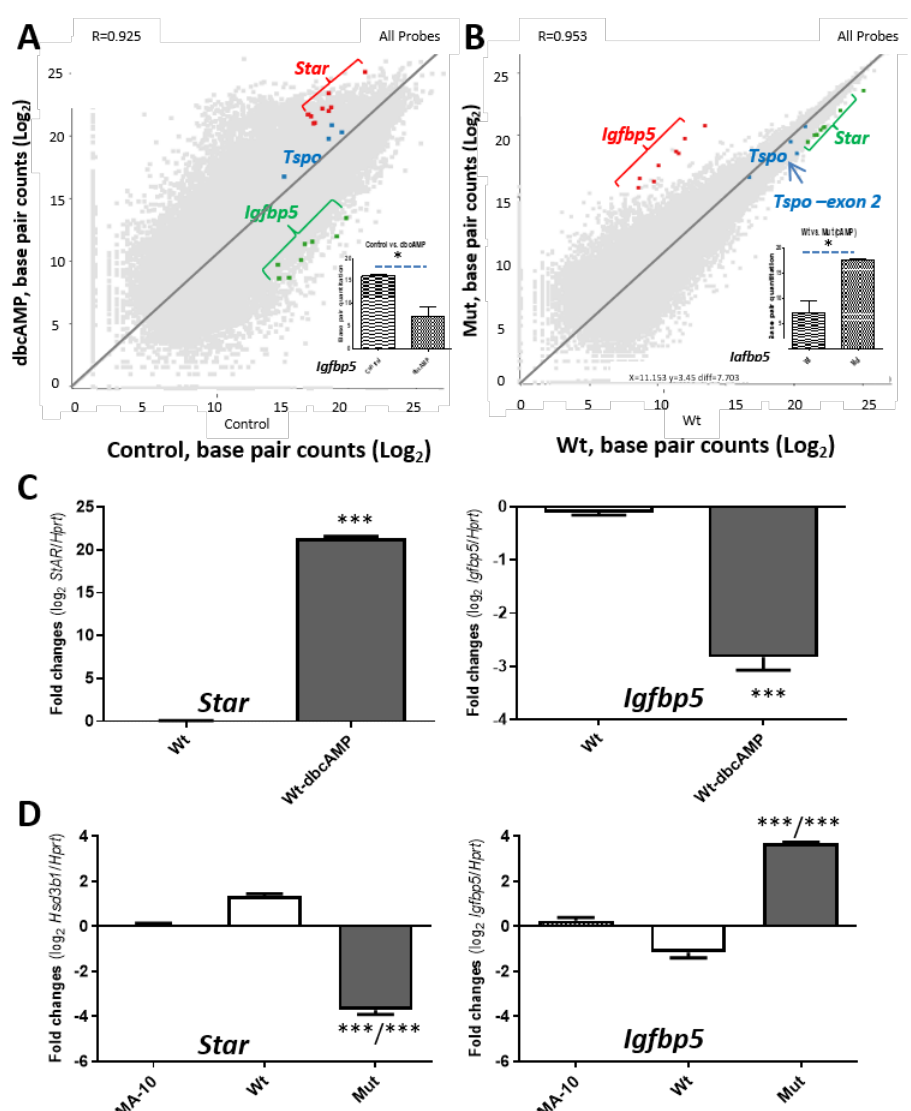
Figure 4. Possible compensatory mechanism to the loss of TSPO reflected in specific gene analysis. ( A ). A low expressed gene, insulin like growth factor binding protein 5 ( Igfbp5 ), in comparisons with highly induced Star and slightly higher expressed Tspo in response to dbcAMP. ( B ). The opposite effect on three genes in response to Tspo mutation. The highly induced Igfbp5 gene under TSPO depletion is highlighted, whereas Star and Tspo were used as gene expression control(s). Inset, the bar graph is the base pair quantitation of each exon of the Igfbp5 gene. *, p value < 0.05 (Student t -test; n = 3). ( C , D ). Real-time PCR of Star and Igfbp5 in response to dbcAMP stimulation in Wt cells ( C ) and to TSPO depletion in MA-10, Wt and Mut cells ( D ). ***, p value < 0.001 (student t -test, n = 3).